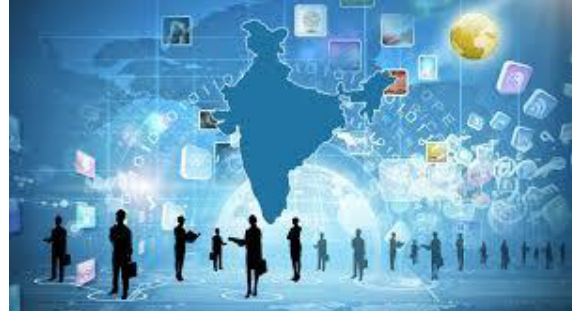
Fig 6. Vision of a True Digital